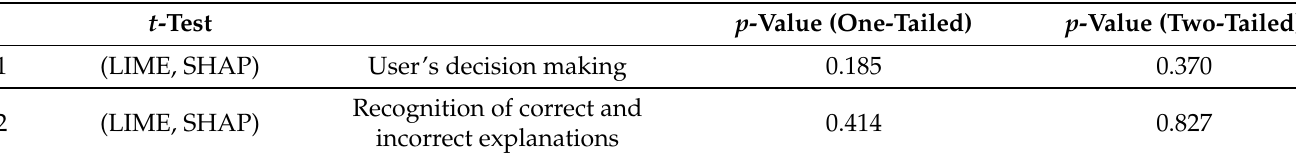
Table 11. Comparison between LIME and